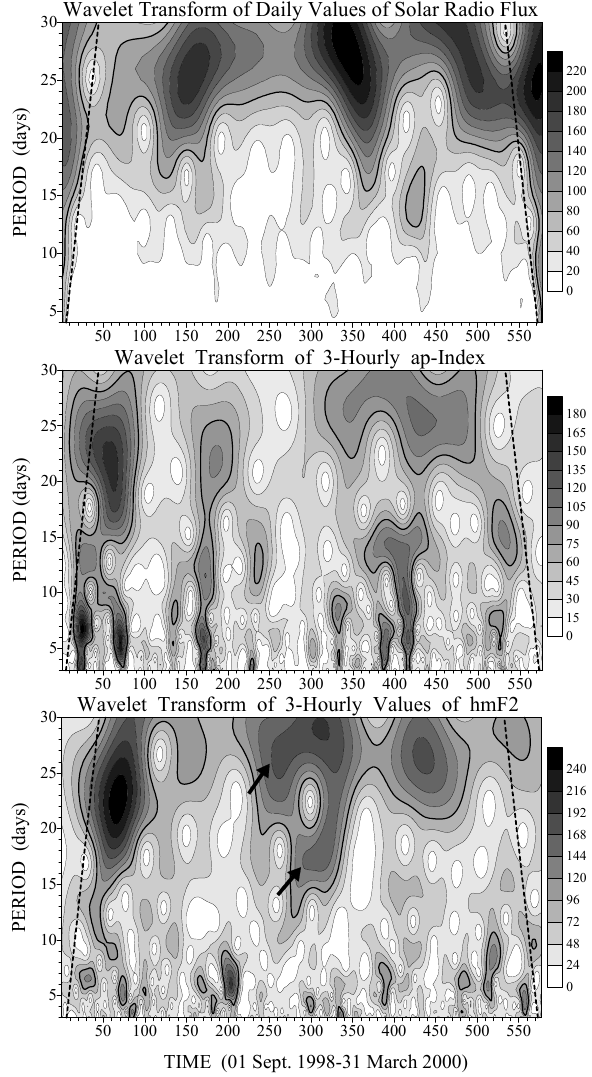
Fig. 1. Wavelet spectra of the solar radio flux F10.7 (upper plot), the geomagnetic A p -index (middle) and the maximum height of the F2-layer over Millstone Hill (bottom) in the period range 3–30days. The thick dashed lines indicate the regions where edge effects be- come important. The thick contour lines represent the 95% confi- dence